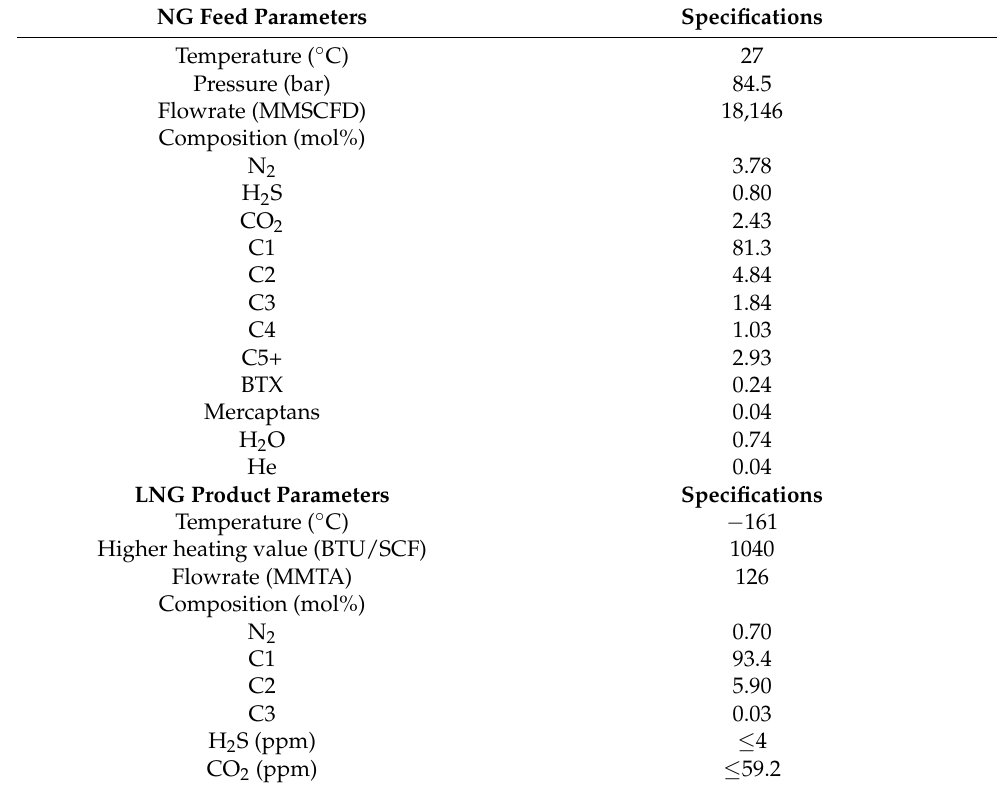
Table 2. Chain feed conditions and products’